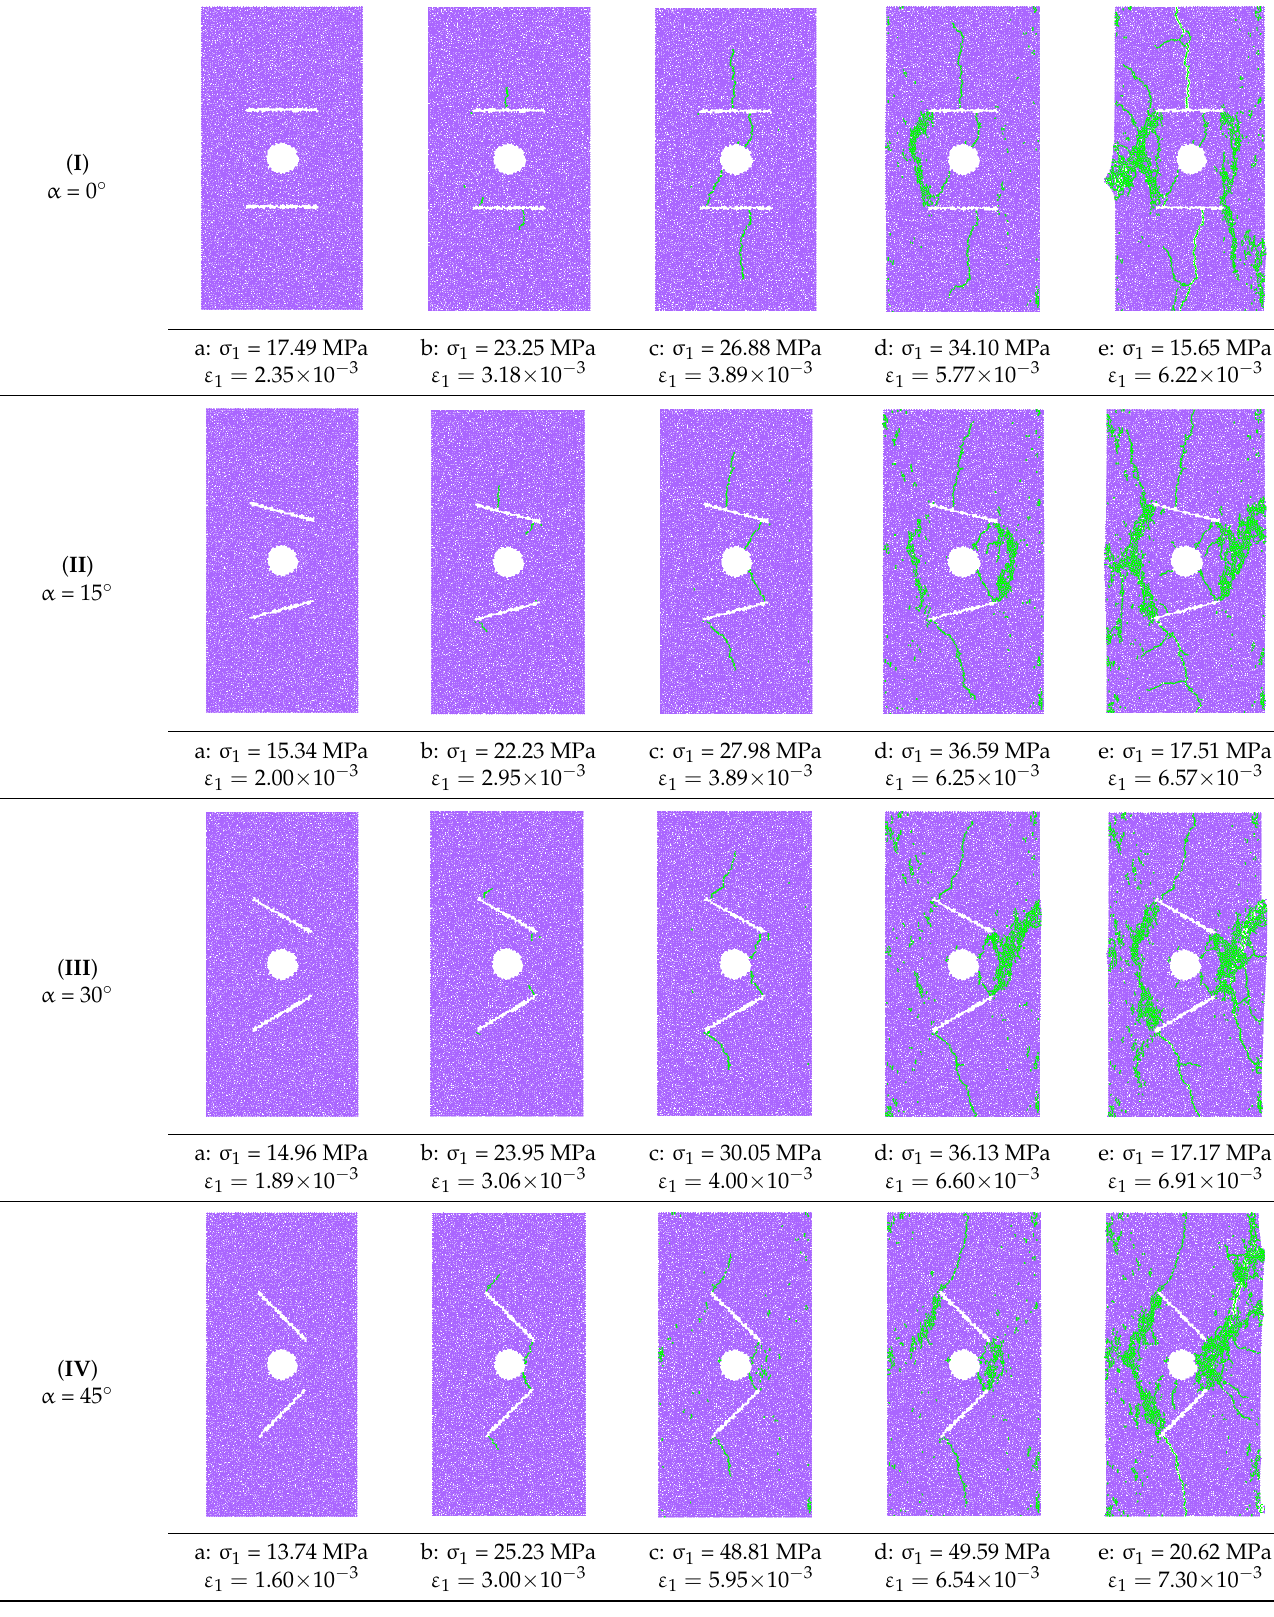
Table 5. Crack evolution of numerical samples with cracks and a single circular hole under uniaxial compression.